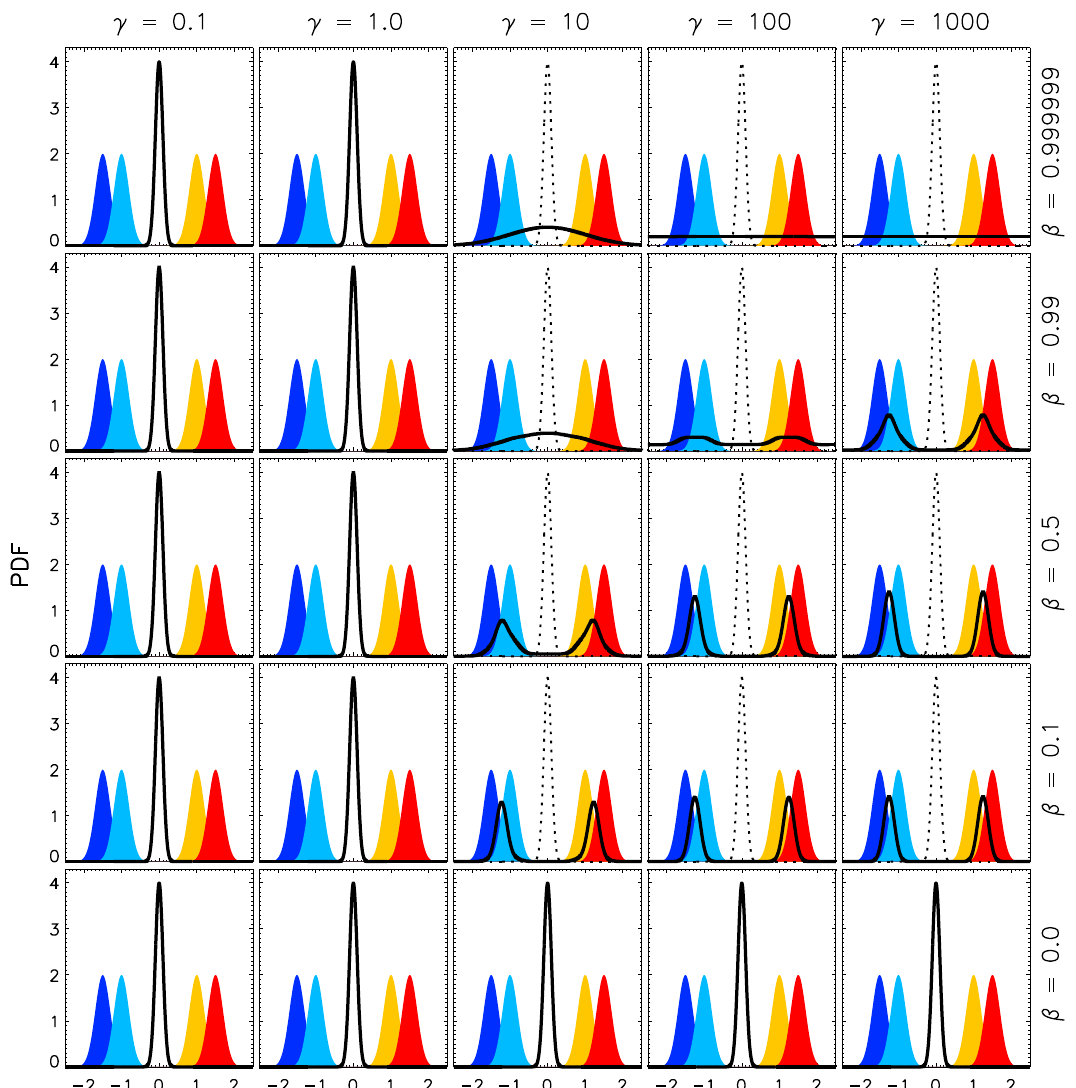
Figure A3. Example of Box–Tiao effect on idealized data with a mean of − 1 . 5, − 1.0, 1.0, and 1.5 (arbitrary units), with blue, cyan, yellow, and red, respectively, all with the same uncertainty σ = 0 . 2. Dotted lines in all plots represent the pdf resulting from multiplying all data treating them as independent. The solid black line represents the pdf following the Box–Tiao equation. Values of γ and β used in the Box–Tiao equation in each plot are shown along the upper and right